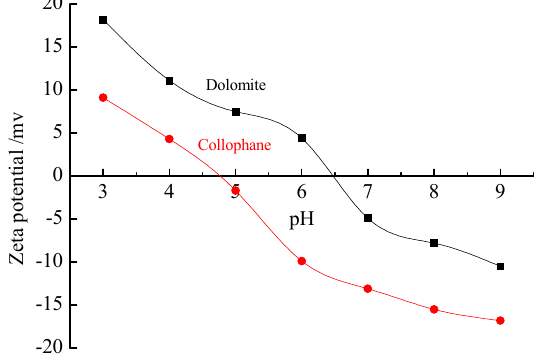
Figure 8. Effect of pH on zeta potential.